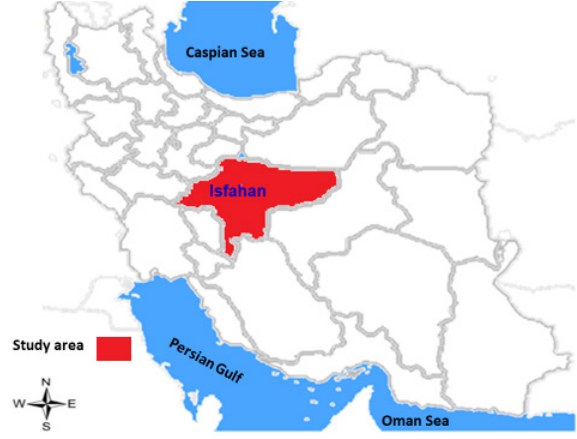
Figure 1. The position of Isfahan province in Iran.